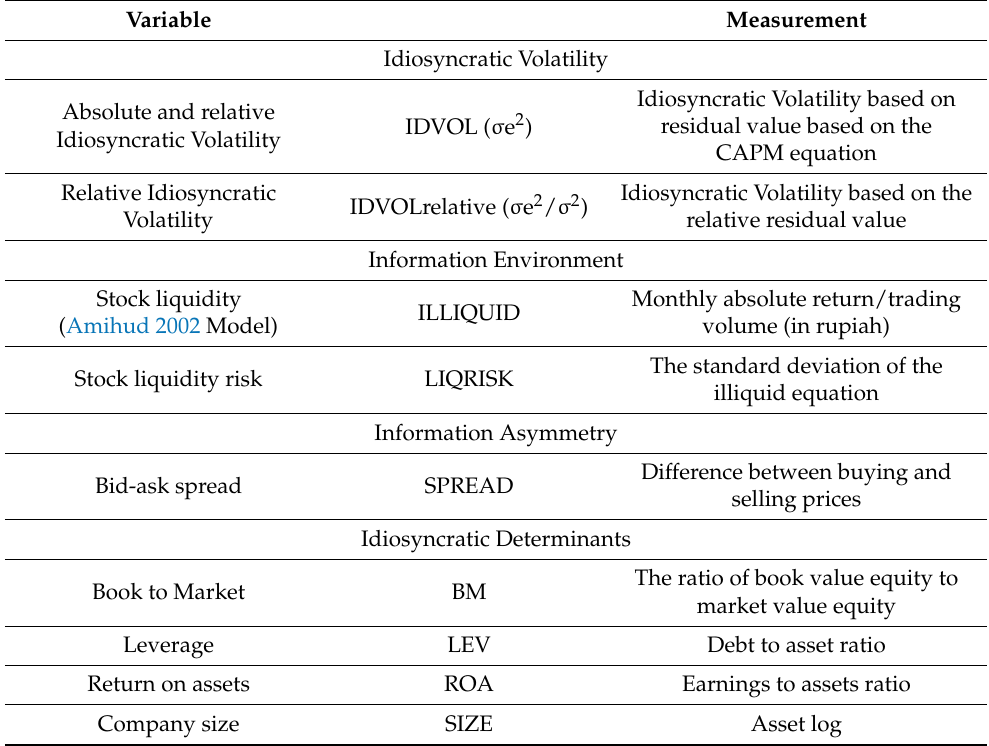
Table 1. Variables and their